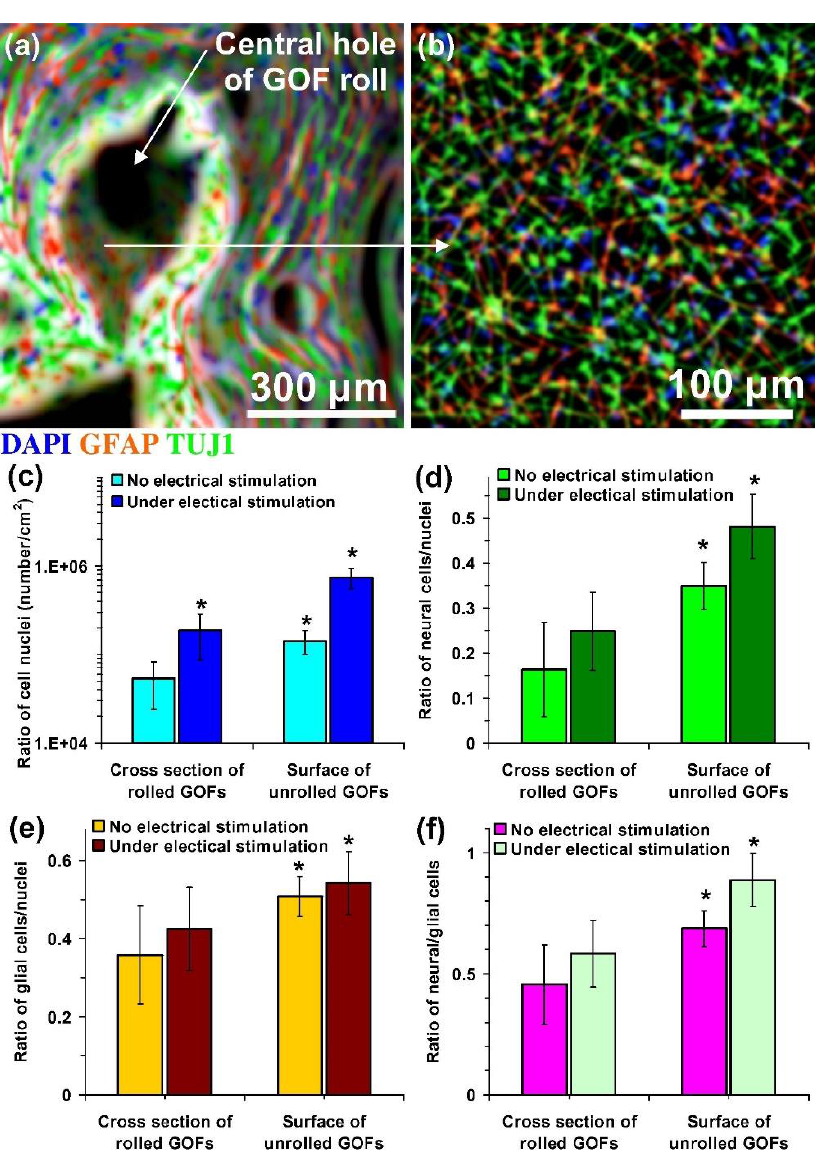
Figure 8. Fluorescent images of hNSCs differentiated on ( a ) cross-section and ( b ) interior surface of a rolled-GOF scaffold after two weeks of electrical stimulation. The nuclei, glial, and neural cells of the differentiated cells were stained by DAPI (blue colour), GFAP (red colour), and TUJ1 (green colour), respectively. ( c ) The number of cell nuclei per surface area of the images and ratio of the number of ( d ) glial cells (GFAP-positive cells) and ( e ) neural cells (TUJ1-positive cells) to the number of nuclei and ( f ) neural/glial cell ratios on cross-section and interior surface of the scaffolds after two weeks differentiation in the absence and the presence of electrical stimulation. Significant results are indicated by asterisks ( ∗ ) for p -values <0.05 ( n = 5). Reproduced with permission from Ref. [138]; copyright (2016), Elsevier.